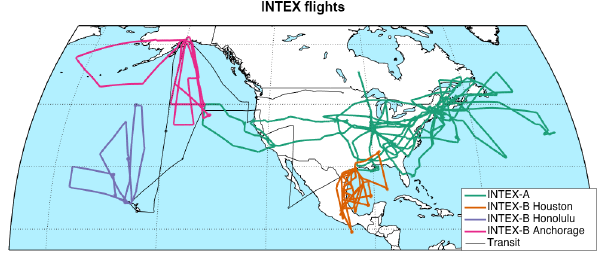
Figure 1. Map of INTEX-A & INTEX-B